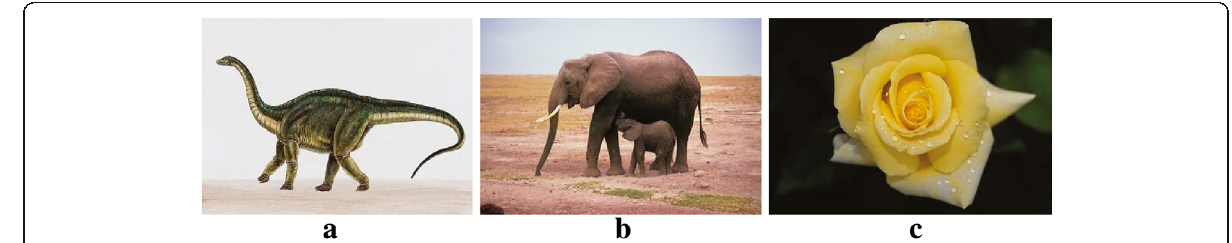
Fig. 9 a – c Sample images of the COREL